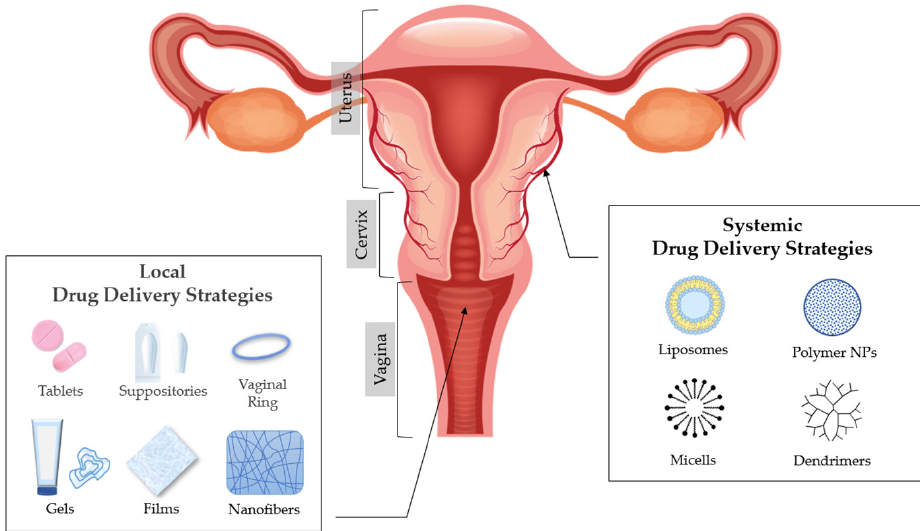
Figure 2. Anatomy of the vagina and drug delivery strategies.